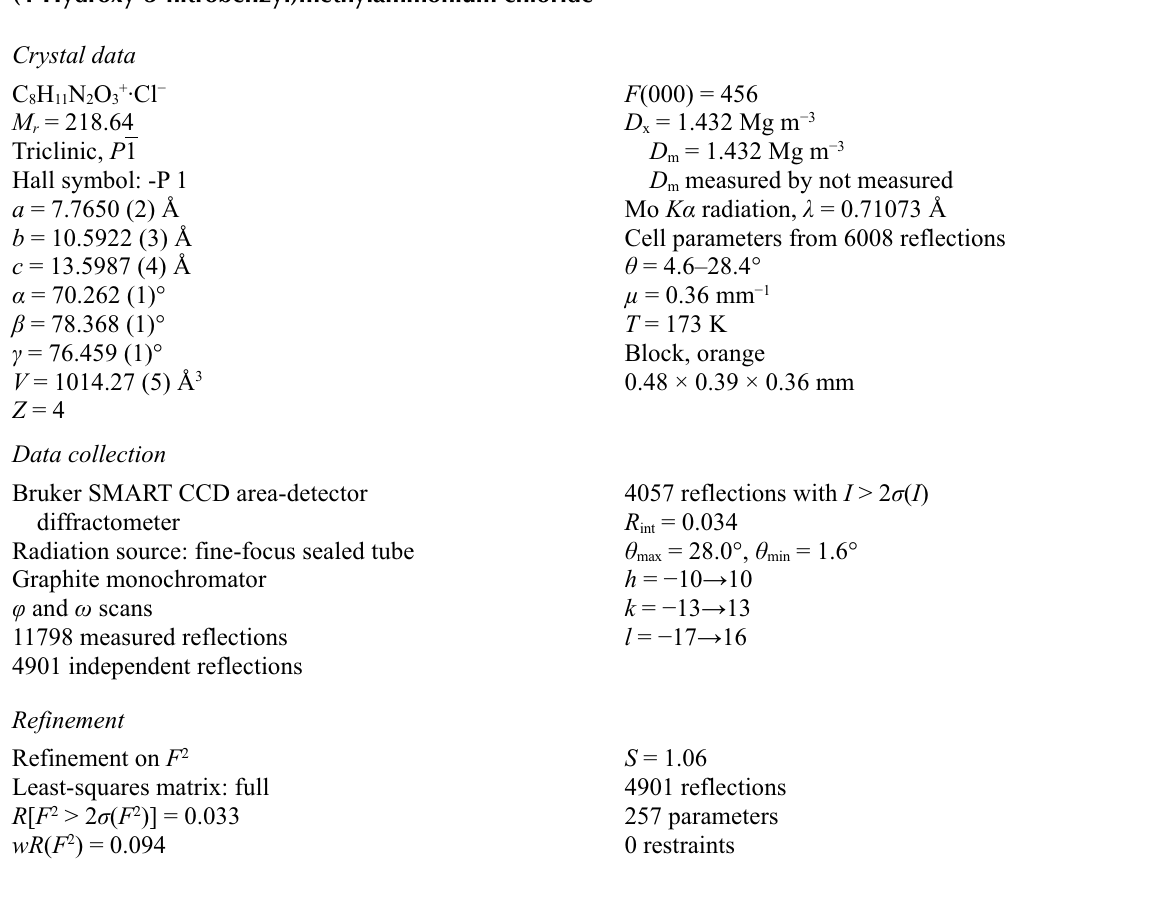
Depiction of the packing. Hydrogen atoms have been omitted for